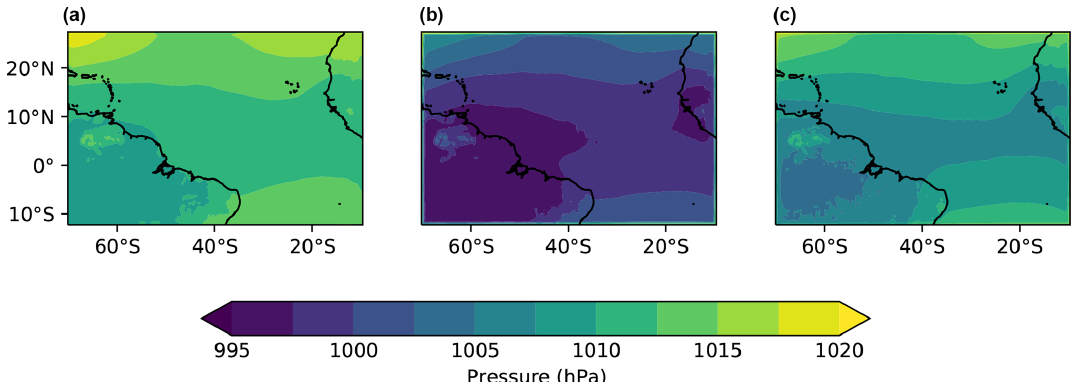
Figure 9. Mean sea level pressure in PGW simulations and the effect of maintaining the hydrostatic balance. (a) Mean sea level pressure in the reanalysis-driven CTRL simulation of the month of November 2004. Panel (c) shows the PGW simulation where the full PGW procedure described in Sect. 2 was followed, including the pressure adjustment. (b) As (c) but using a simplified procedure where the pressure at the lateral boundaries was left unchanged. The computational domain covers the tropical Atlantic. Note the significant differences between panels (b) and (c) , highlighting the importance of the pressure adjustment. Technical simulation details are in Table A1.